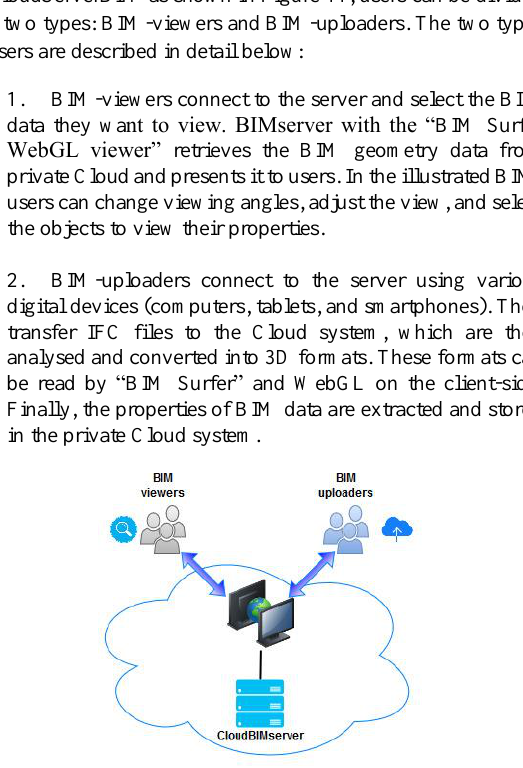
Figure 11. System framework with two types of users (viewers and